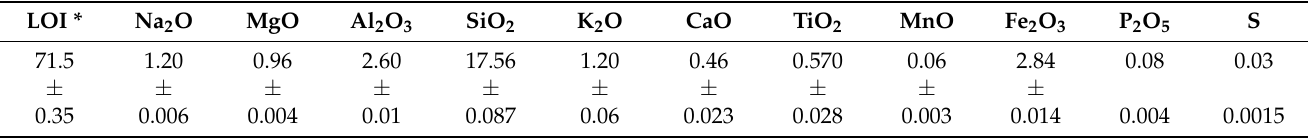
Table 3. Chemical composition of the bottom sediments measured via X-ray fluorescence analysis, %